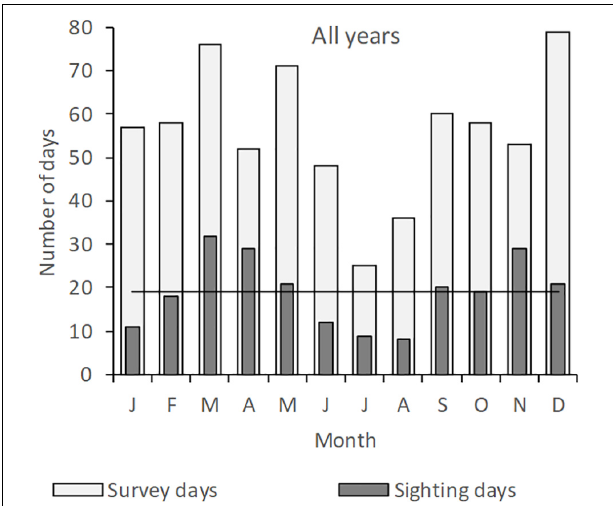
FIGURE 2 | Total monthly survey efforts (number of survey days) and numbers of days with cetacean sighting during the Wakatobi cetacean monitoring program from May 2004 to May 2012. Horizontal line (–) indicates mean number of days with cetacean sighting over all months. T1, Transition 1 season (March–May); SE-Mons, SE Monsoon season (June–August); T2, Transition 2 season (September–November); SW-Mons, SW Monsoon season